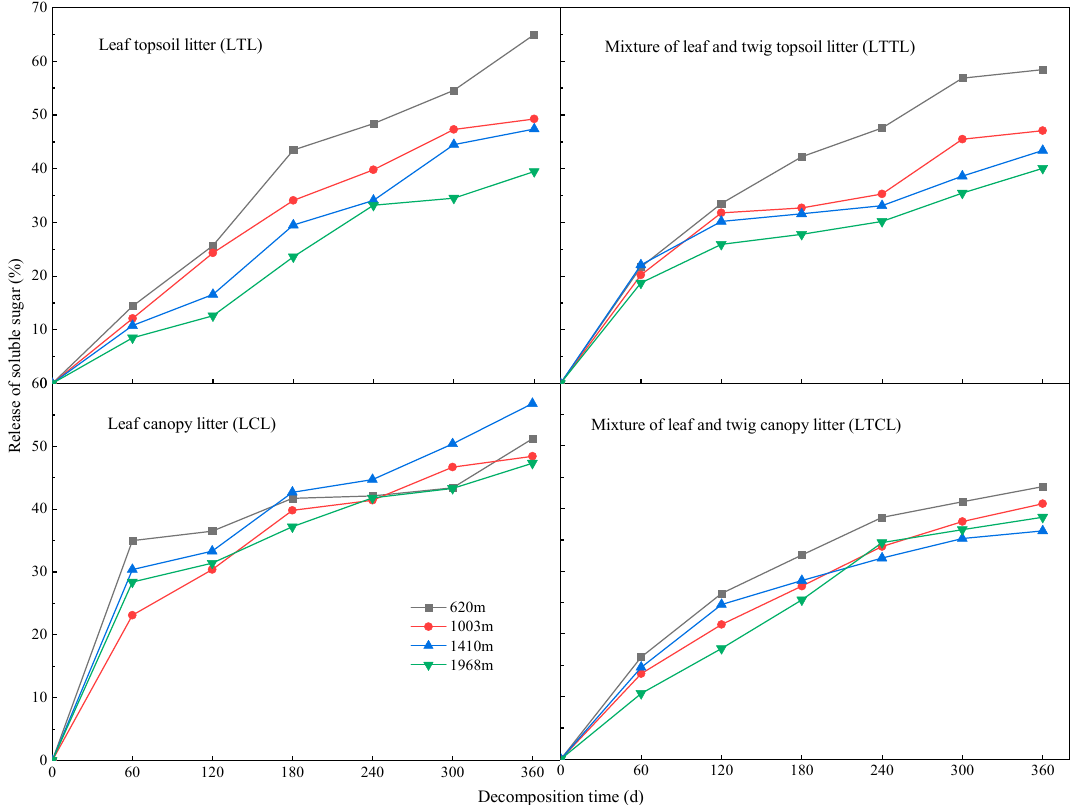
Figure 1. Cumulative release of soluble sugar in Chinese fir topsoil litter and canopy litter at different altitudes.